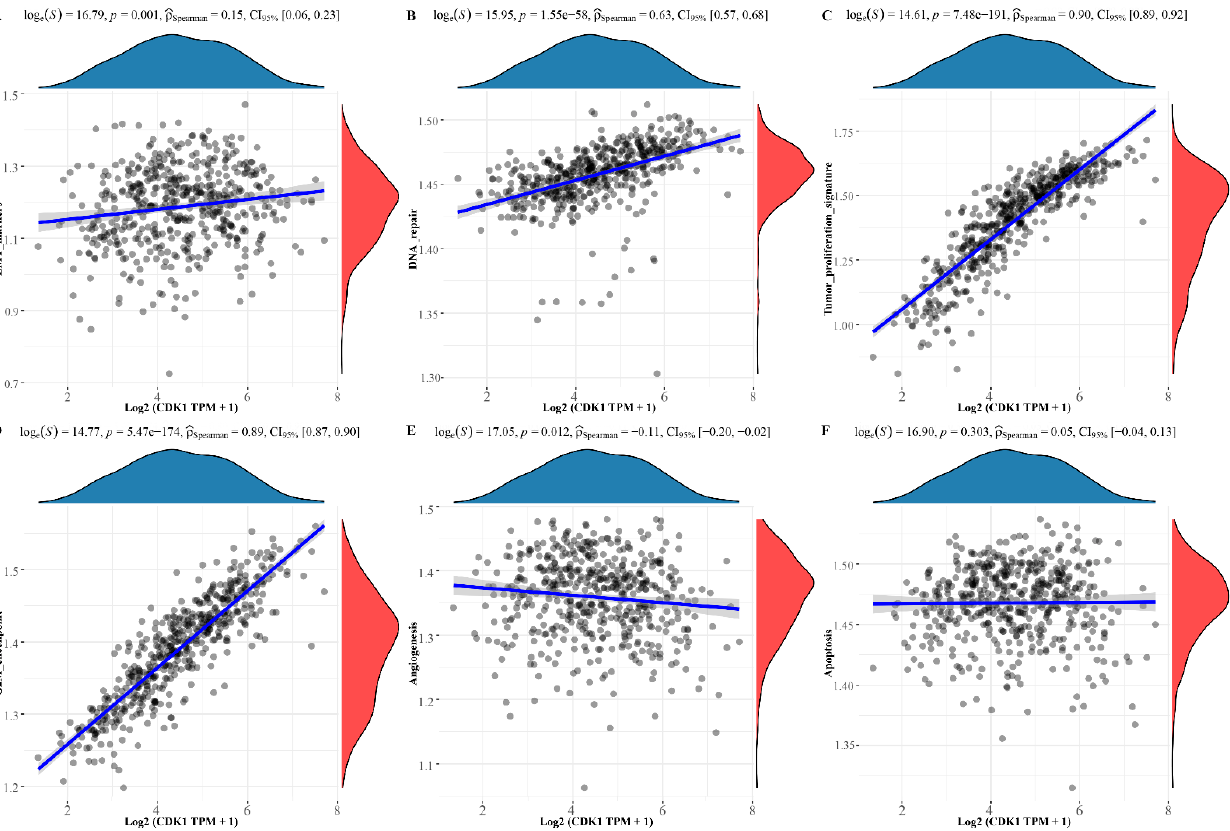
Figure 6. Pathway correlation analysis of CDK1. ( A ) EMT makers. ( B ) DNA repair. ( C ) Tumor proliferation. ( D ) G2-M checkpoint. ( E ) Angiogenesis. ( F ) Apoptosis.